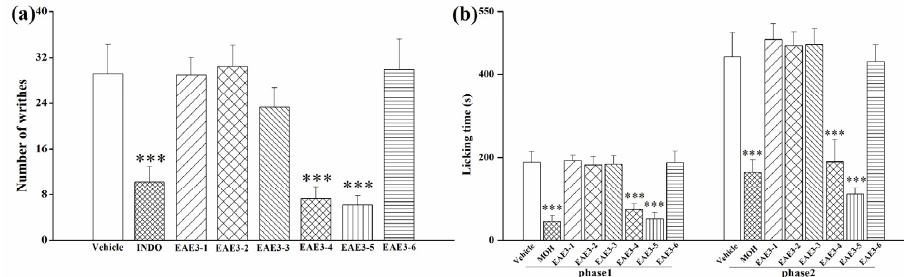
Figure 1. Antinociceptive effects of fractions of EAE3 in antinociceptive tests. 10 mg/kg of frac- tions from EAE3 in the writhing test ( a ) and the formalin test ( b ). Vehicle: blank control, INDO: indomethacin, MOH: morphine hydrochloride. Data are displayed as mean ± SD, *** p < 0.001 vs. vehicle